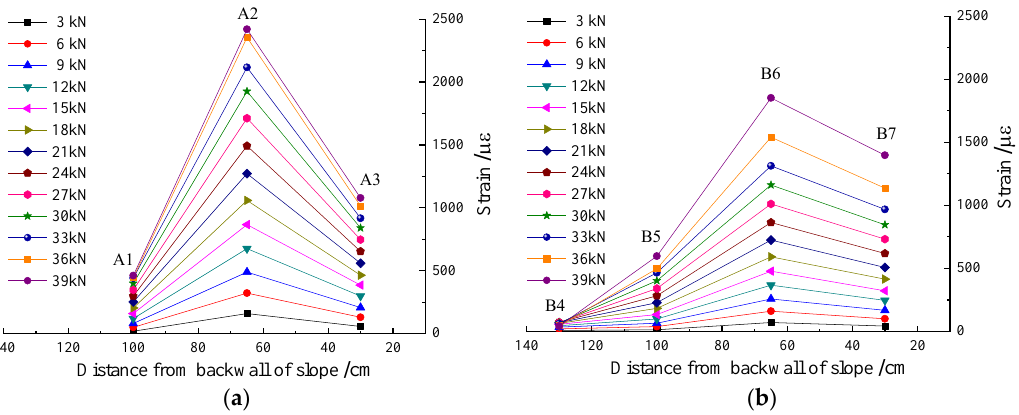
Figure 6. FBG-measured strain distribution of geogrid under different loads. ( a ) Geogrid A; ( b ) Geogrid B.